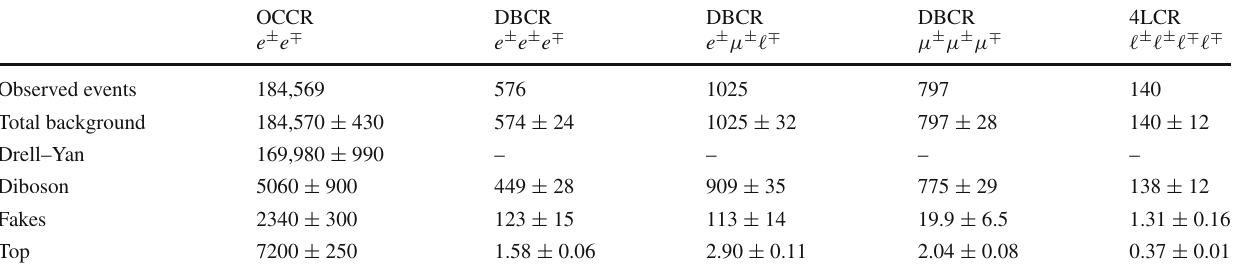
Table 5 The number of predicted background events in control regions after the fit, compared to the data. Uncertainties correspond to the total uncertainties in the predicted event yields, and are smaller for the total than the sum of the components in quadrature due to correla-